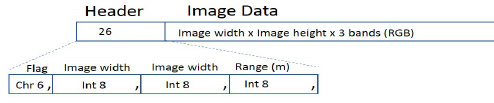
Figure 5. Structure of the message transmitted by the Oculus SDK to Python